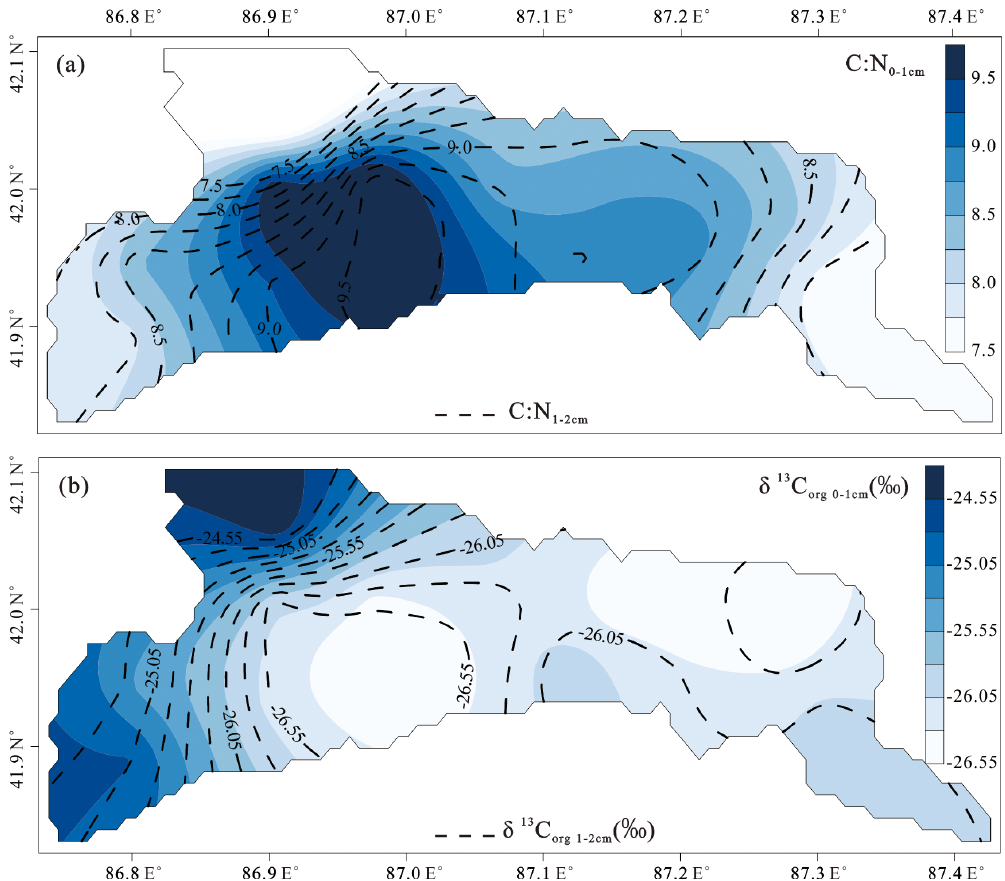
Figure 4. Spatial distribution of (a) C:N ratio and (b) carbon stable isotope ( δ 13 C org ) of TOC in the 0–1cm (color map) and 1–2cm (dashed lines). Table 1. Correlation coefficient ( r ) between various variables for the sediments. Variables WD DBD d (0.5) Clay Silt Sand TOC δ 13 C org TOC 0.50 − 0.58 a − 0.71 b 0.18 0.77 b − 0.76 b − 0.15 TN 0.07 − 0.83 b − 0.60 a − 0.05 0.79 b − 0.72 b 0.71 b 0.45 C:N 0.50 0.50 0.01 0.25 0.14 − 0.82 b δ 13 C org − 0.66 a − 0.46 − 0.13 0.03 0.21 − 0.20 − 0.15 POC − 0.42 − 0.41 0.11 − 0.29 0.11 − 0.02 0.14